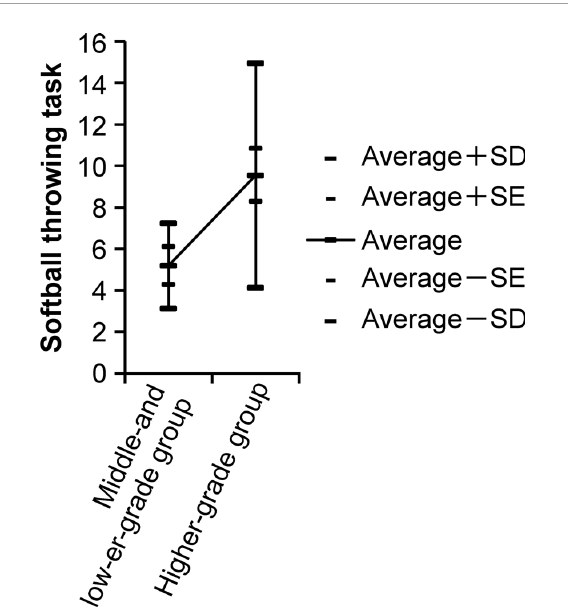
FIGURE2 The distance of the second-grade softball throw and the results of the analysis of variance for the higher-grade group and middle- and lower-grade groups in arts and